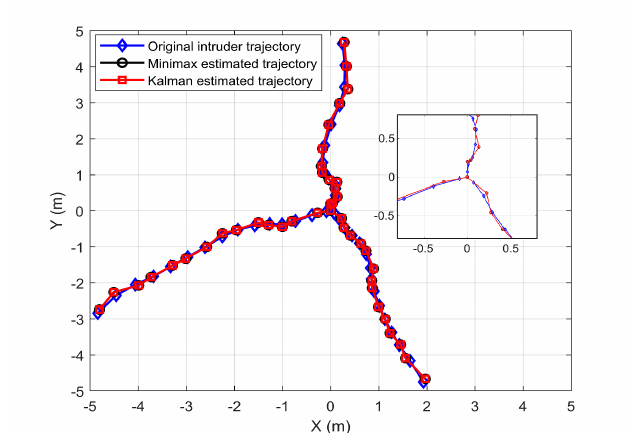
Figure 2. The actual and estimated (using minimax and Kalman filters) trajectories of the random paths of three different intruders, tracked using